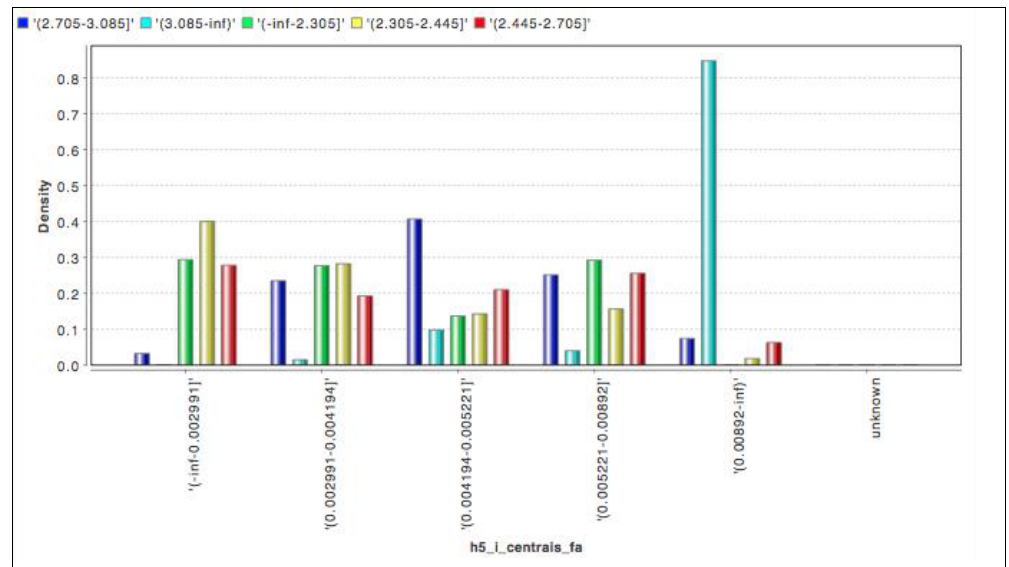
Figure 5 - Densidad de probabilidad de intervalos discretos de THDv con relación a la corriente del 5º armónico.